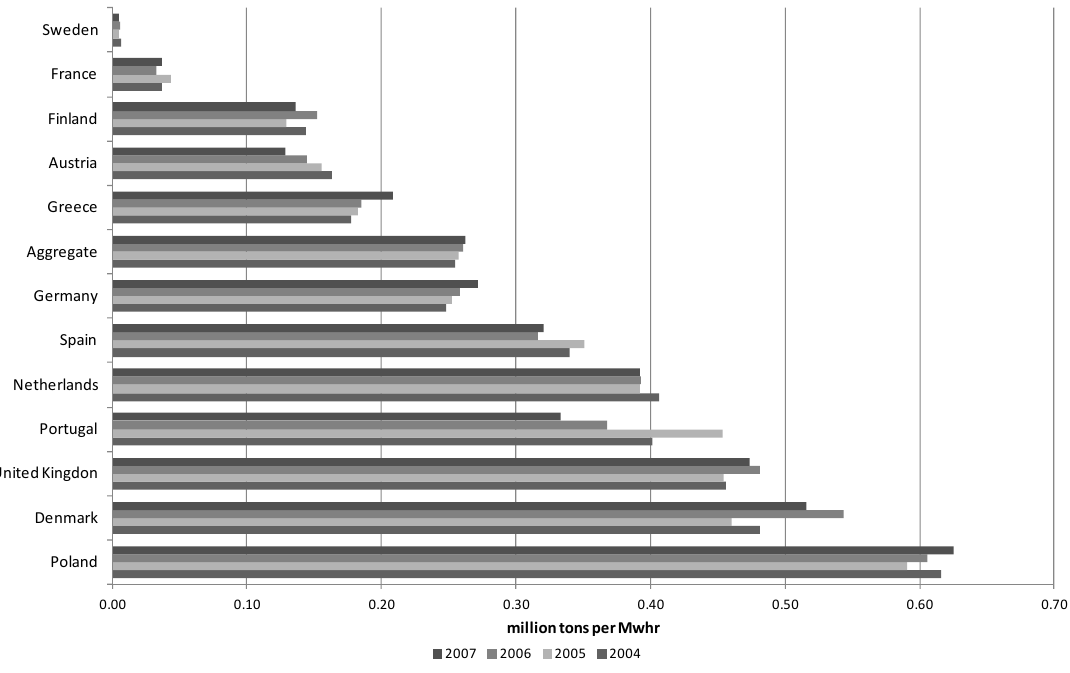
Figure 1. Carbon intensity of indigenous electricity production by country, 2004 to